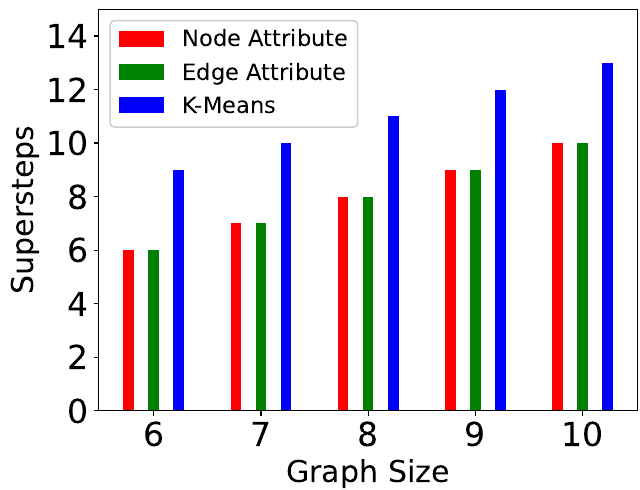
Figure 13. Supersteps in